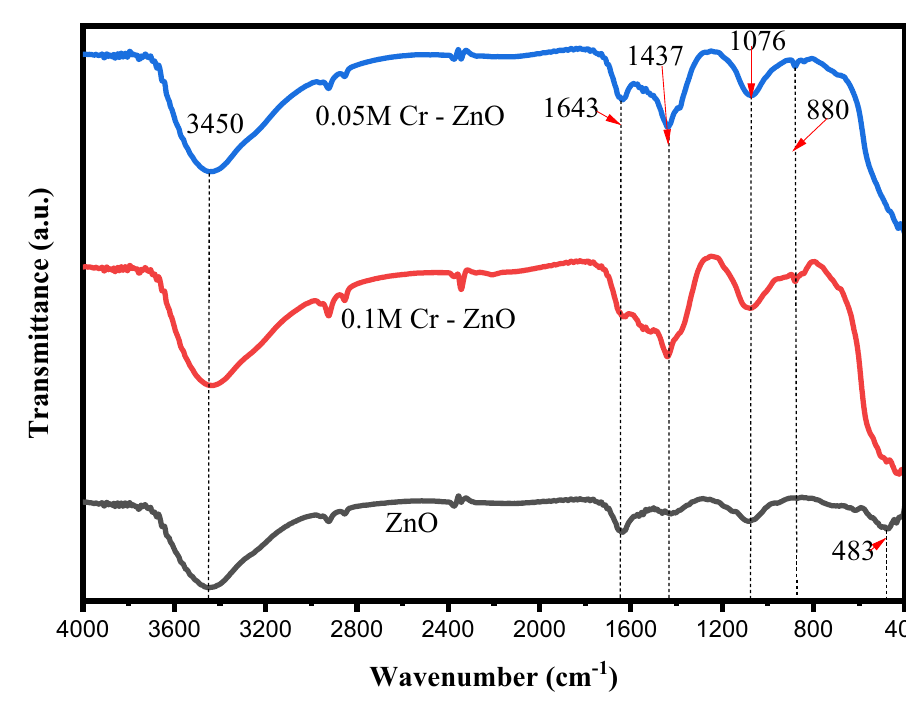
Fig. 3 FTIR spectra of ZnO, and Cr doped ZnO